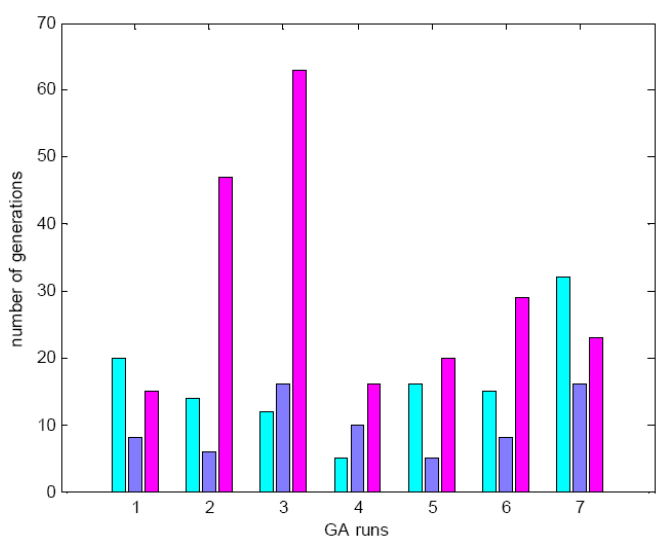
Figure 6. Statistical results for an NSCT2